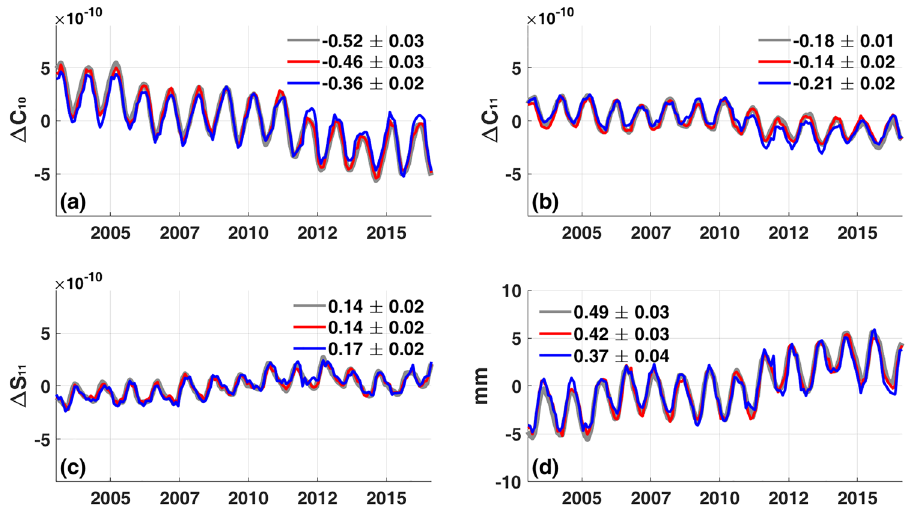
Figure 4. Estimates of degree-1 terms and their effects on GMOM from synthetic GRACE-like data. ( a )–( c ) Gray lines are true degree-1 SH coefficients. Red and blue lines are estimated degree-1 SH coefficients from synthetic GRACE-like synthetic data including ROD1 and ROD2, respectively. ( d ) Gray line is true GMOM only considering degree-1 terms over Altimeter- Argo regions. Red and blue lines are GMOM using estimated degree-1 SH coefficients with ROD1 and ROD2, respectively. Numbers in each panel are linear trends with associated 95% confidence